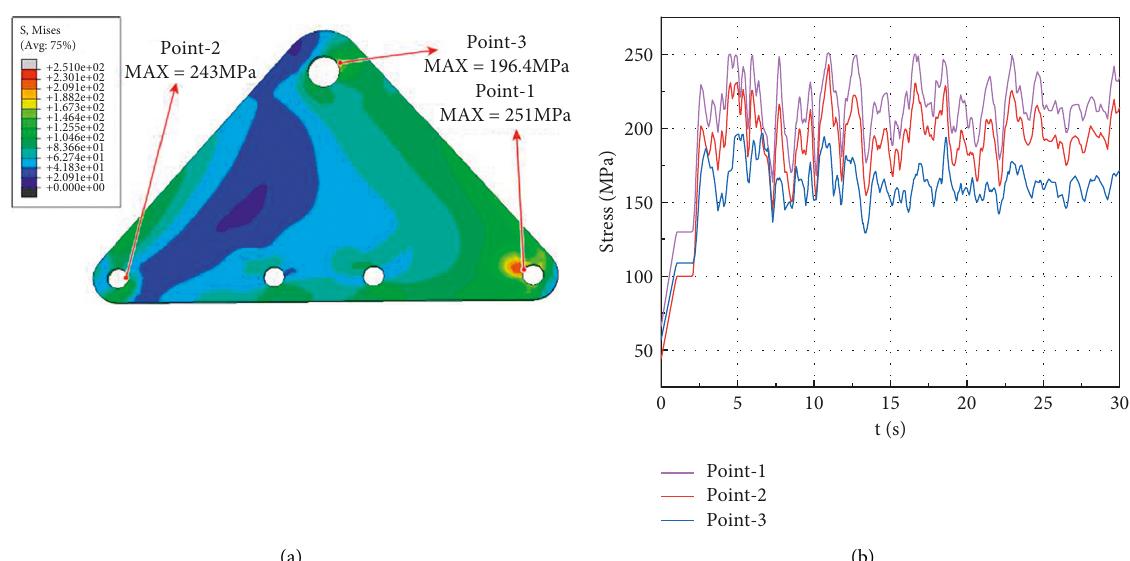
Figure 39: Triangle hanging plate connected with the iced conductor: (a) stress cloud picture; (b) stress-time curve of each hanging